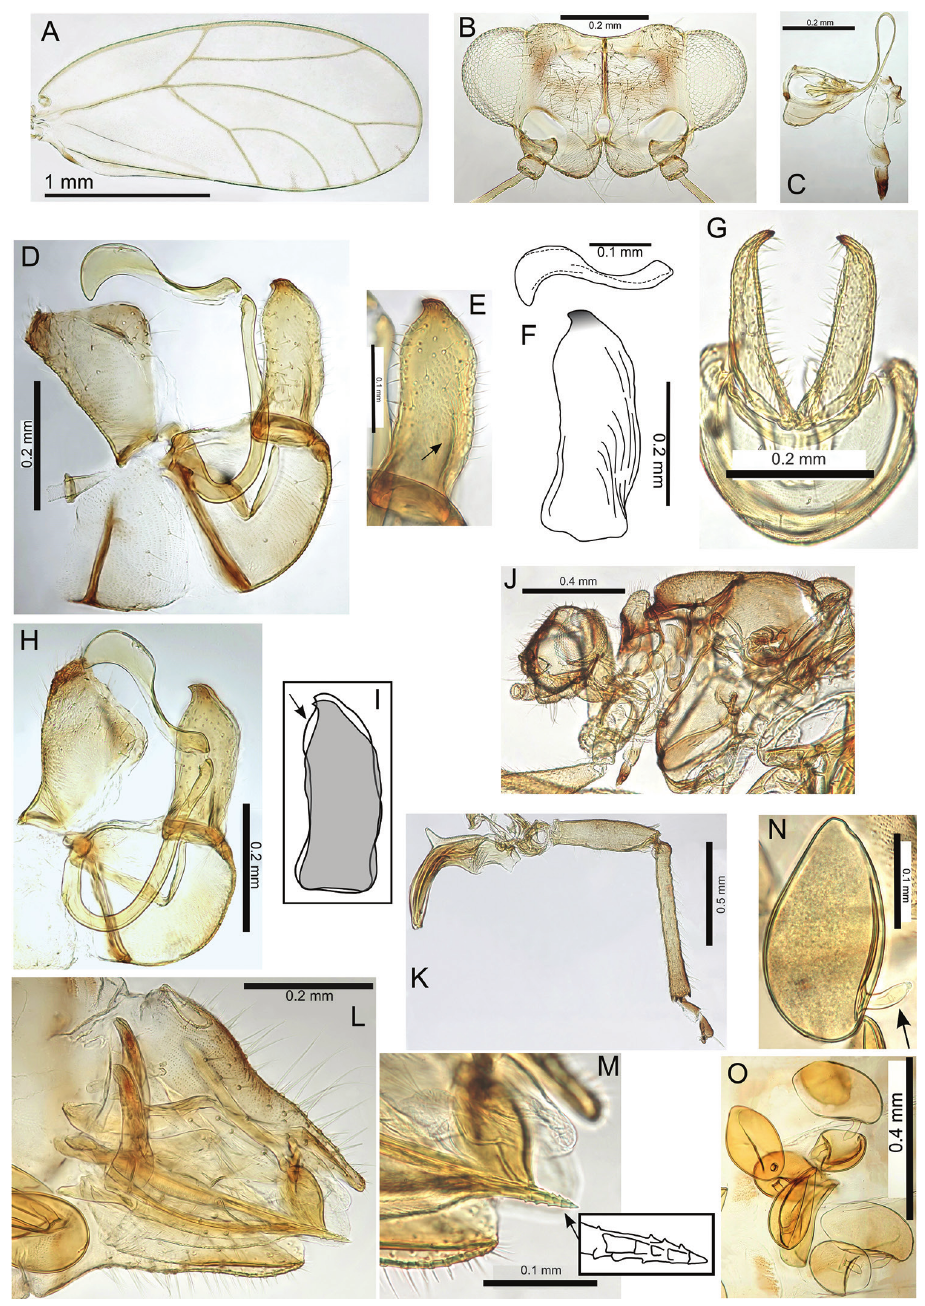
Figure 22. Pariaconus hiiaka sp. n. A fore wing B head C proboscis D male terminalia E paramere F aedeagus and paramere G male terminalia (posterior view) H male terminalia (variation) I paramere shape variation comparison J head and thorax K hind leg L female terminalia M ovipositor (serrations indicated) N, O eggs (pedicel